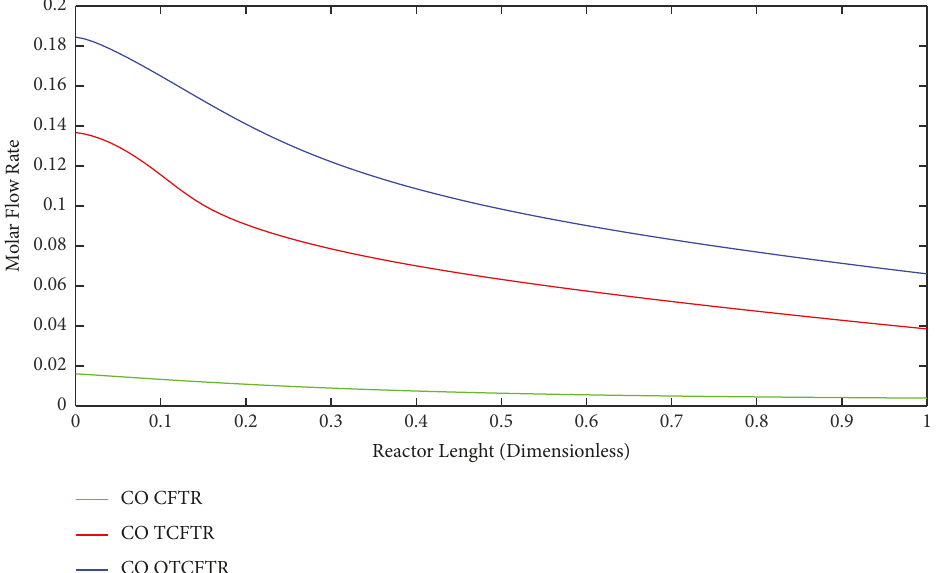
Figure 12: CO molar flow rate along the reactor length in CFTR, TCFTR, and OTCFTR